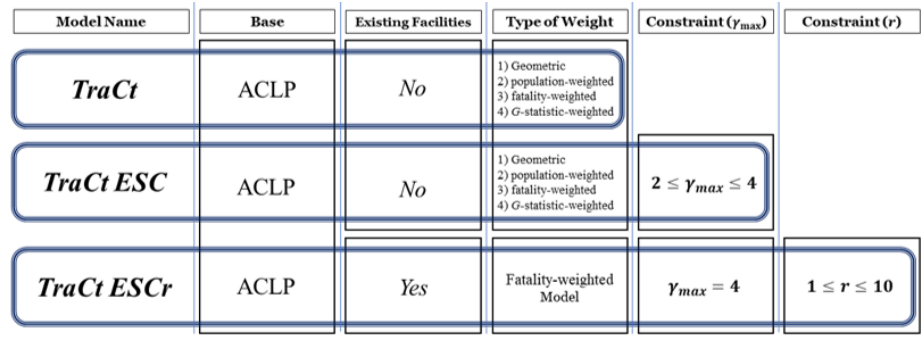
Figure 5. Structure of the modeling approach by different types of weight and